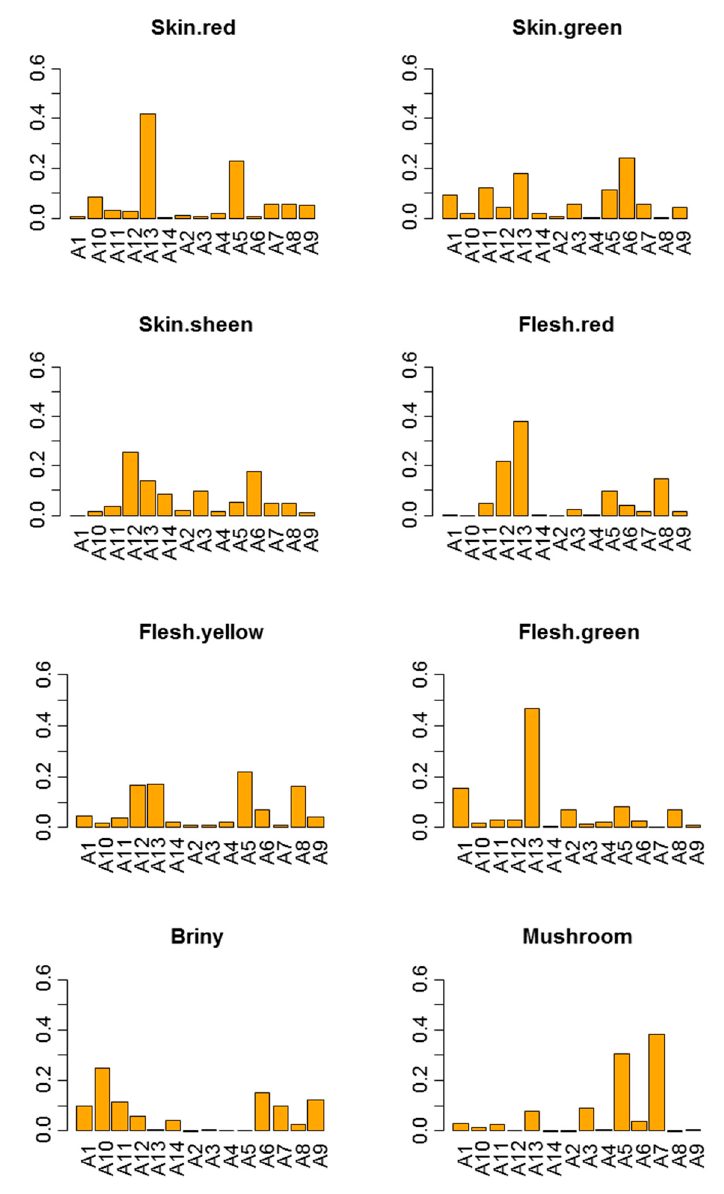
Figure 4. Panel performance. Panelist · session interaction. Contribution (coefficients) of panelists to the interaction for selected descriptors (skin red, skin green, skin sheen, flesh red, flesh yellow, flesh green, briny, and mushroom).